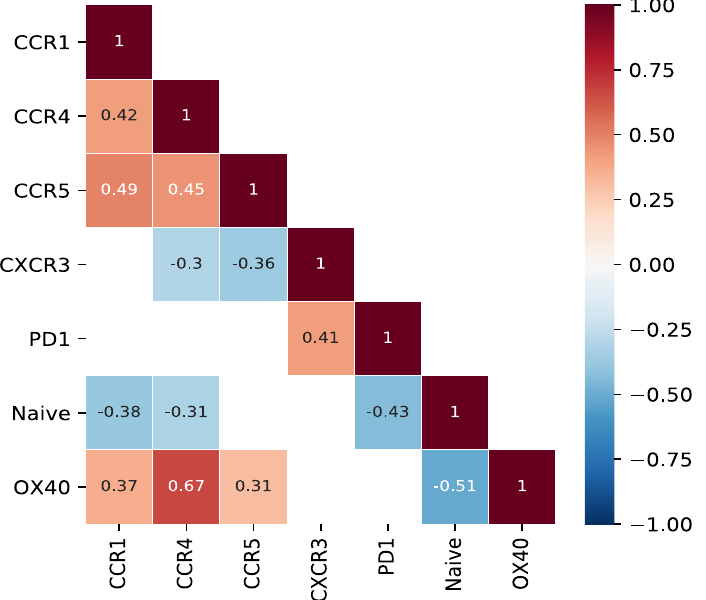
Figure 6. Frequency of CD8+ T cells expressing CCR1, CCR4 and/or CCR5 correlates positively with frequency of CD8+ T cells expressing OX40, and negatively with frequency of naïve CD8+ T cells. Correlation heatmap showing Spearman correlation coefficients between frequencies of CD8+ T-cell subsets expressing selected coinhibitory, co-stimulatory, chemo-attractant receptors as well as maturation markers from Figures 2–5. Only significant correlations are shown ( p value <